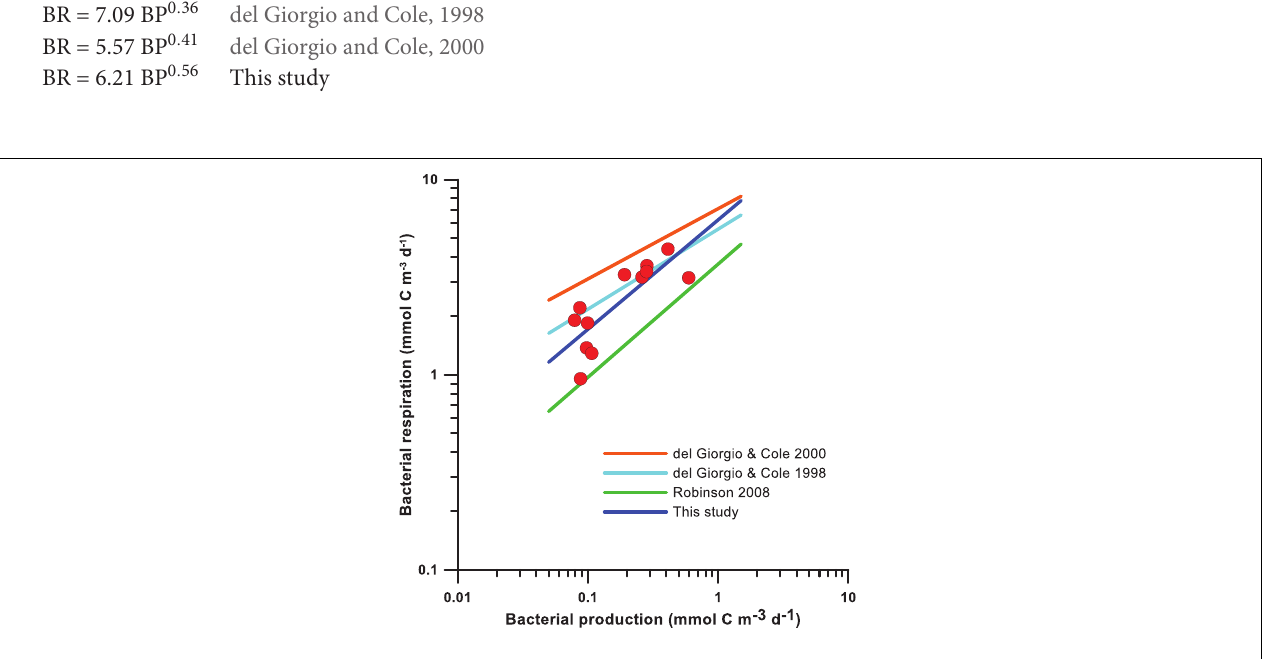
Frontiers in Marine Science |